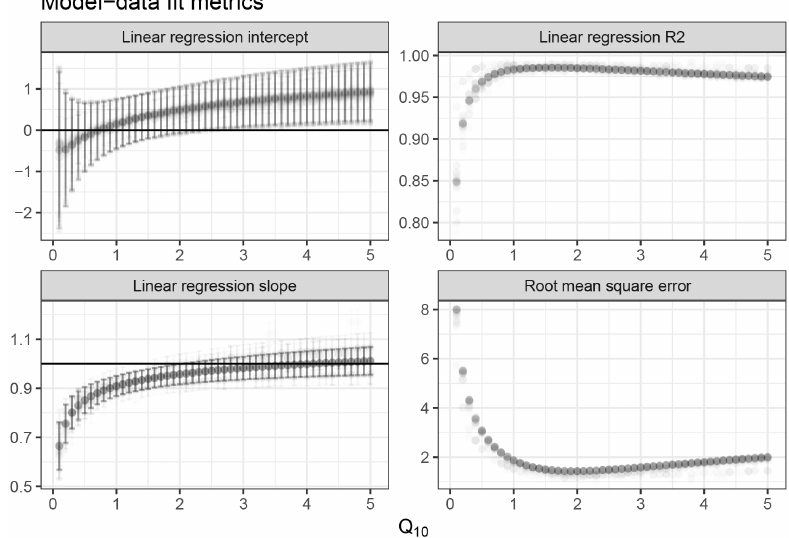
Figure 1. The model–data fits across different Q 10 values for random subsets of 34 sites including the root mean squared error, and linear regression metrics R 2 , slope, and intercept. The model is take from Eq. (4) ( C w = C c Q 2 standard deviation error